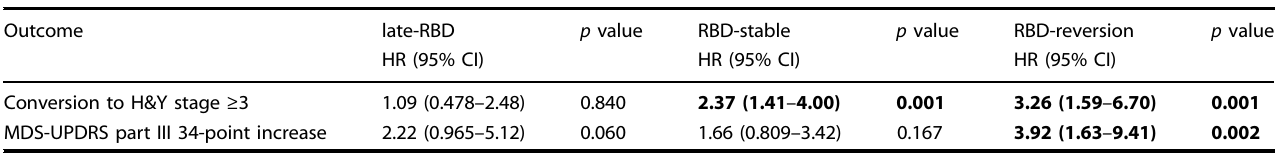
Fig. 2 Kaplan – Meier survival curves for progression-free survival according to pRBD evolution pattern. Time from baseline to a Hoehn – Yahr stage ≥ 3, b 34-point increase in Movement Disorder Society Uni fi ed Parkinson ’ s Disease Rating Scale part III, c mild cognitive impairment according to MDS criteria (<1.5 SD on 2 or more tests), d Montreal Cognitive Assessment score <26 at 2 consecutive visits. Ticks indicate censoring events. Table 2. Estimated HRs for motor progression in different pRBD evolution